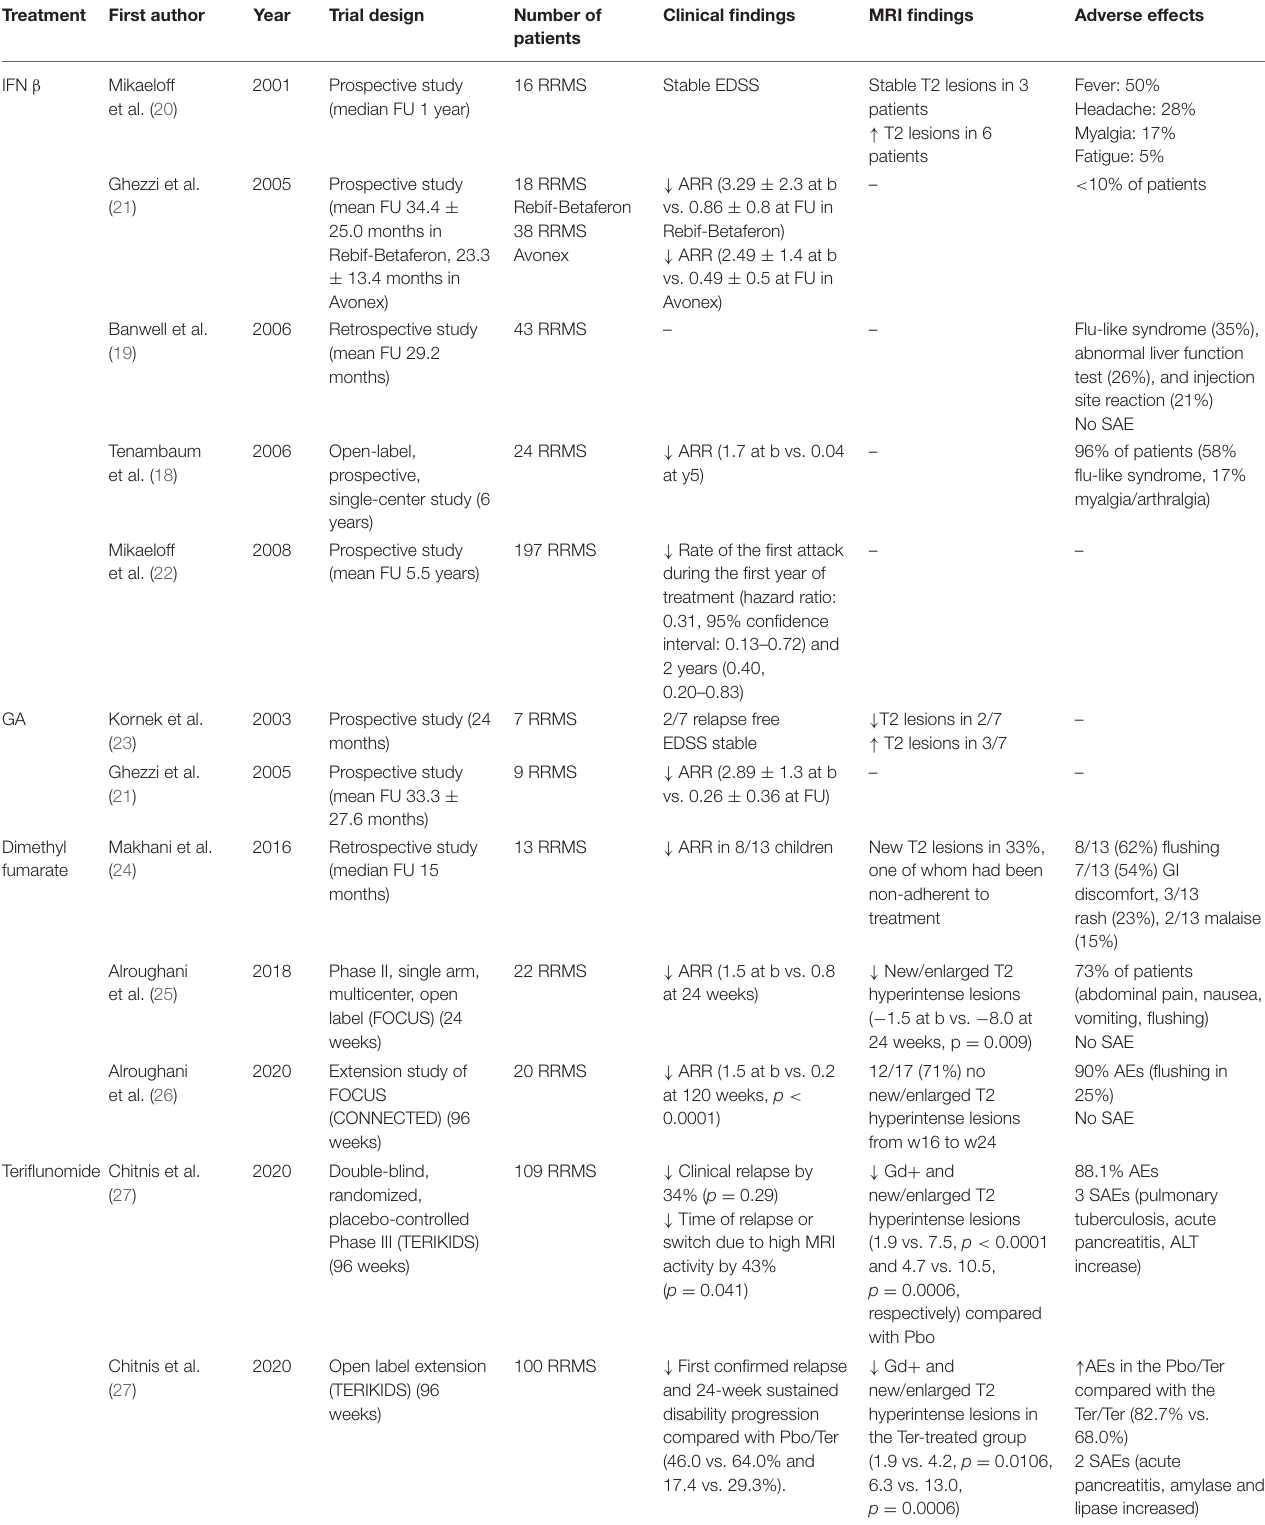
TABLE 1 | Observational and clinical studies on first-line immunomodulatory therapies in pediatric multiple sclerosis. Treatment First